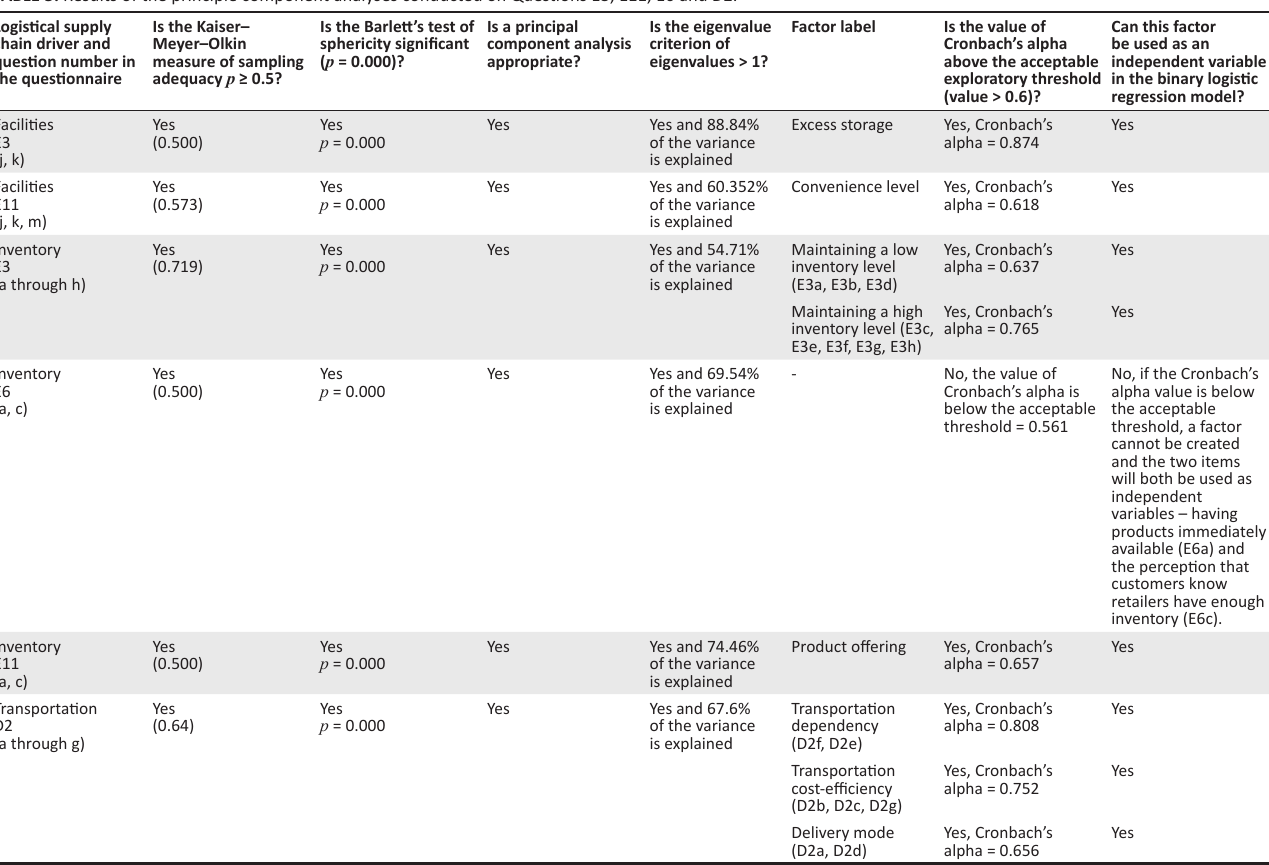
TABLE 3: Results of the principle component analyses conducted on Questions E3, E11, E6 and D2. Logistical supply chain driver and question number in the